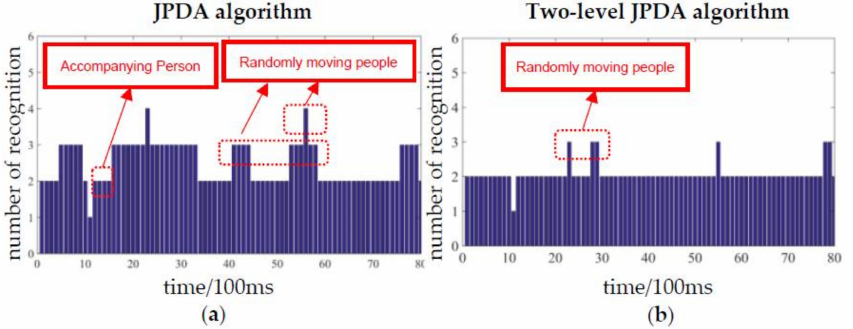
Figure 8. The comparison of the target recognition results. ( a ) JPDA algorithm. ( b ) Two-level JPDA algorithm.